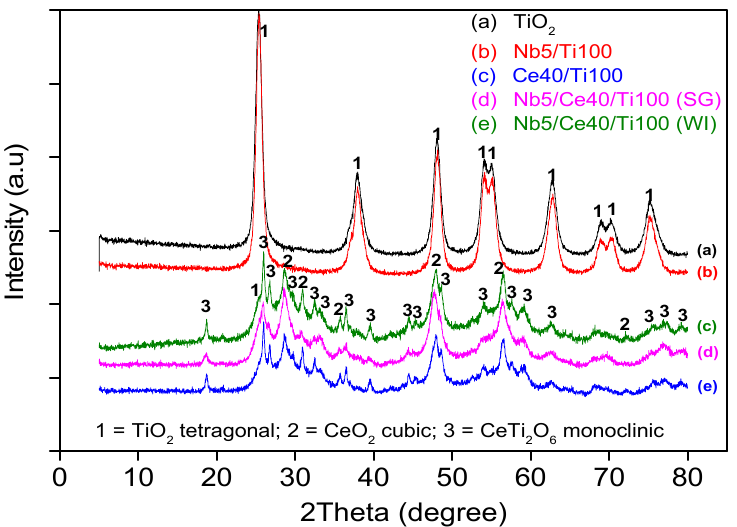
Figure 3. N 2 adsorption-desorption isotherms and BJH pore distributions for all fresh catalysts: ( a ) TiO 2 , ( b ) Nb5/Ti100, ( c ) Ce40/Ti100 (SG), ( d ) Nb5/Ce40/Ti100 (SG), ( e ) Nb5/Ce40/Ti100 (WI).